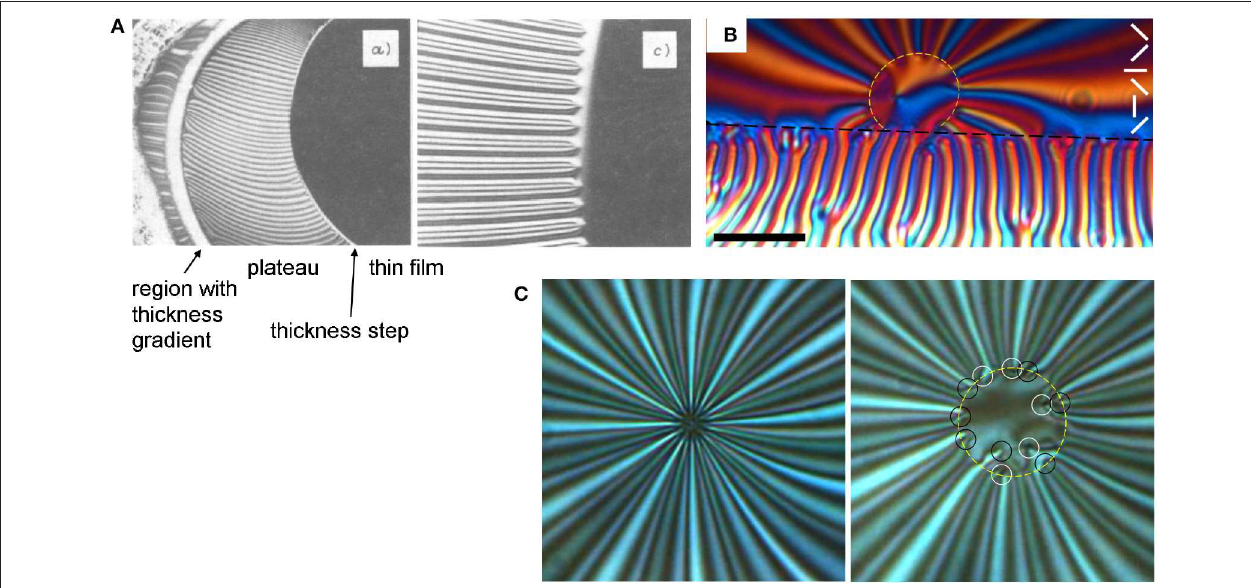
FIGURE 5 | Arrays of 1 point defects pinned at layer steps of free-standing SmC films: (A) A continuous director distortion extends from a stripe pattern in a band of + decreasing thickness (white arc in a), connected to the meniscus at the film holder, across a plateau of homogeneous thickness (striped region in the middle of a), and ending in several 1 point defects at a thickness step toward the thinner film seen in black on the right. The region near the stripe ends is enlarged in (c). Image size of + (c) 455 367 µ m 2 . Figure reproduced from Maclennan [88], copyright IOP Publishing. (B) Defects trapped around a circular film thickness step (yellow dashes), with × its connection to the meniscus (below the black dashed line). Crossed polarizers parallel to the edges, with wave plate at 45 ◦ , scale bar 50 µ m. Adapted from Harth [ 91]. (C) Stripe array with 12 trapped 1 defects in the central region, left: in equilibrium (the thinner region enclosed by the film thickness step is not resolved); + right: after the film is slightly expanded, the 12 individual defects are visible. Because of K S > K B , they are all tangential. Black and white circles mark c , yellow dashes indicate the main layer step trapping the defects. Crossed polarizers parallel to the edges, image dimensions 72 sense of rotation of E Microscopy images taken from Stannarius and Harth [32], copyright American Physical Society, annotations from Harth